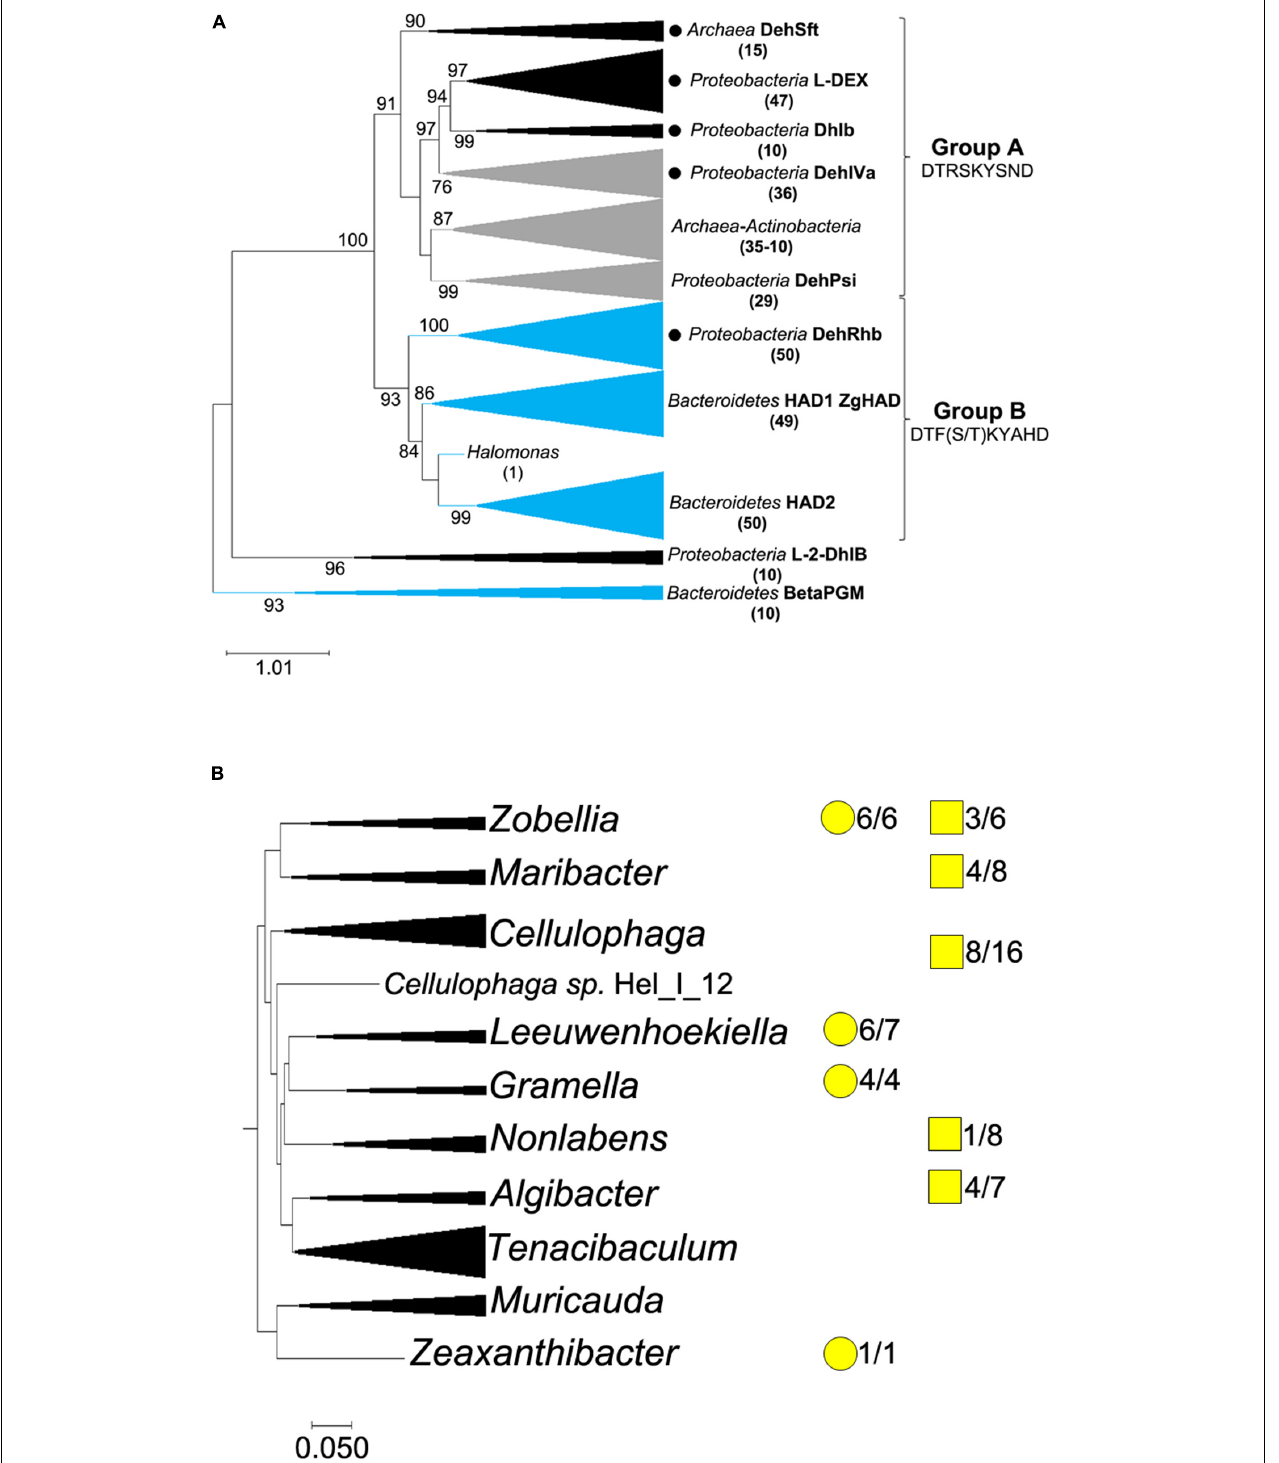
FIGURE 1 | Phylogenetic distribution of L-2-HADs. (A) Maximum likelihood phylogenetic tree based on L-2-HAD protein sequences. Group A and group B define the two major phylogenetic groups, for which nine specifically conserved amino acids of the catalytic site are shown. Black circles indicate phylogenetic clades with at least one available 3D structure of L-2-HAD. Black branches represent putative L-2-HAD proteins from terrestrial or freshwater organisms, blue branches represent those from a large majority of marine organisms and gray ones are those for mixed terrestrial/marine groups. The number of sequences in each group